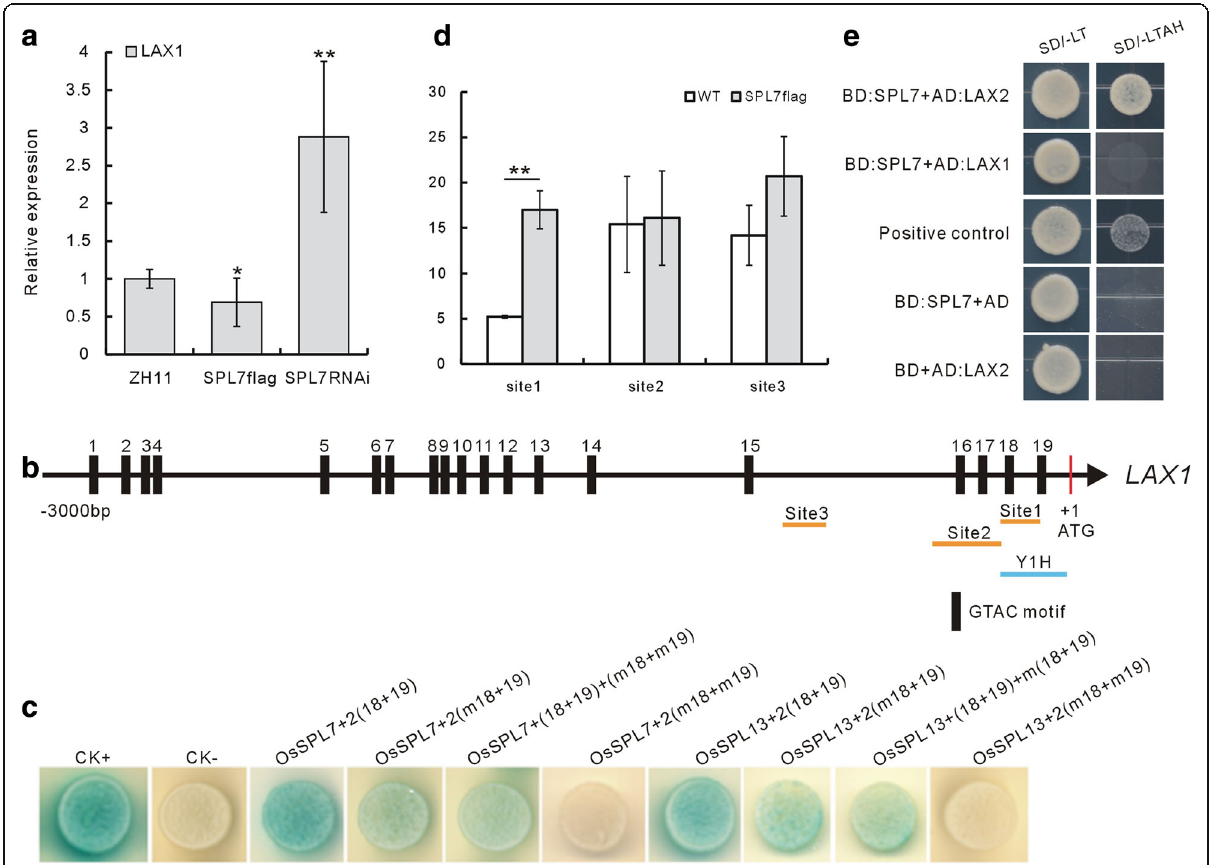
Fig. 4 Direct regulation of OsSPL7 to LAX1 and Y2H of OsSPL7 and LAX2. a Expression analysis of LAX1 gene in the SPL7Flag and SPL7RNAi plants. b Sketch graph of the 19 SPL binding motifs in the 2 Kb promoter of LAX1 gene. Red bar indicates the ATG start codon, and black ones indicate the SPL binding GTAC motifs. Blue line labeled Y1H indicates the fragment site used in Y1H assay. Orange lines indicate the respective sites of the fragments used in ChIP assay. c Y1H assay of the binding of OsSPL7 and OsSPL13 proteins to the 18th and 19th motifs in the promoter of LAX1 gene. m18 and m19 indicate mutant 18th and 19th motifs. 2(18+19) means the fragment containing 2 tandem copies of normal 18th and 19th motifs, 2(m18+19) means the fragment containing 2 tandem copies of m18 and normal 19th motifs, and (18+19)+(m18+m19) means the fragment containing one copy of normal 18th and 19th motif and one copy of m18 an m19, 2(m18+m19) means the fragment containing 2 tandem copies of m18 and m19 motifs. d ChIP analysis using the binding of the OsSPL7 fused flag tag to the promoter of LAX1 gene. Single and double asterisks in ( a ) and ( d ) represent significant difference determined by the Student ’ s t -test at * P <0.05 and ** P <0.01. e Y2H assay of OsSPL7 and LAX2, and OsSPL7 and LAX2. “ SD-LT ” stands for SD media devoid of Leu and Trp amino acids, “ SD-LTAH ” stands for SD media devoid of Leu, Trp, Ade